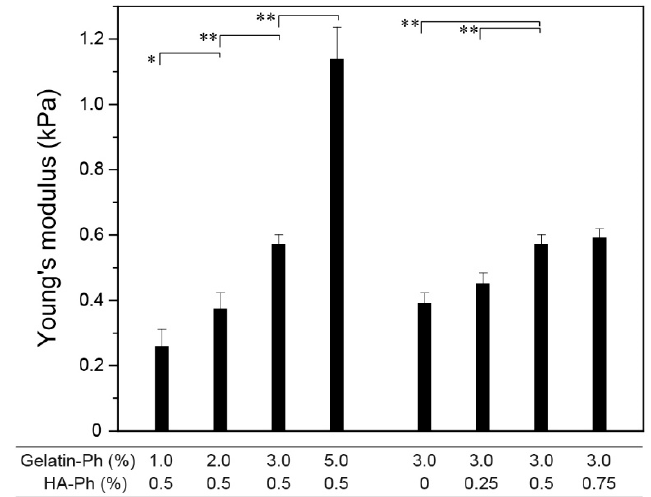
Figure 5. E ff ects of gelatin-Ph and HA-Ph content on Young’s modulus of hydrogels. Bars: S.D. ( n = 4). * p < 0.05, ** p < 0.01.